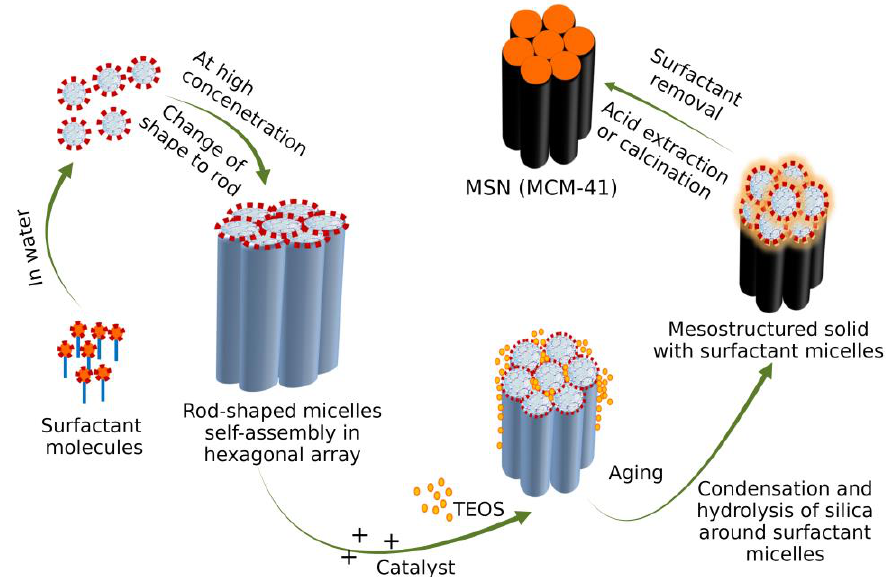
Figure 5. Formation of MCM-41 by sol-gel method. (Figure created using BioRender.com; accessed on 2 December 2022).